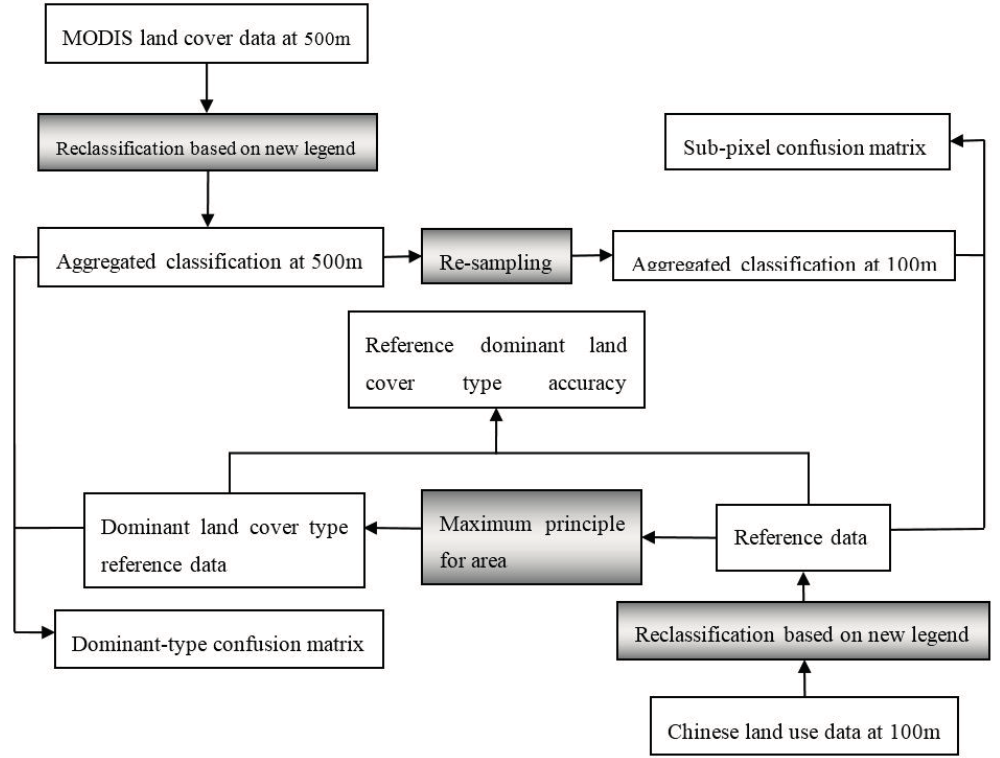
Figure 2. Flow chart for deriving the dominant-type and sub-pixel confusion